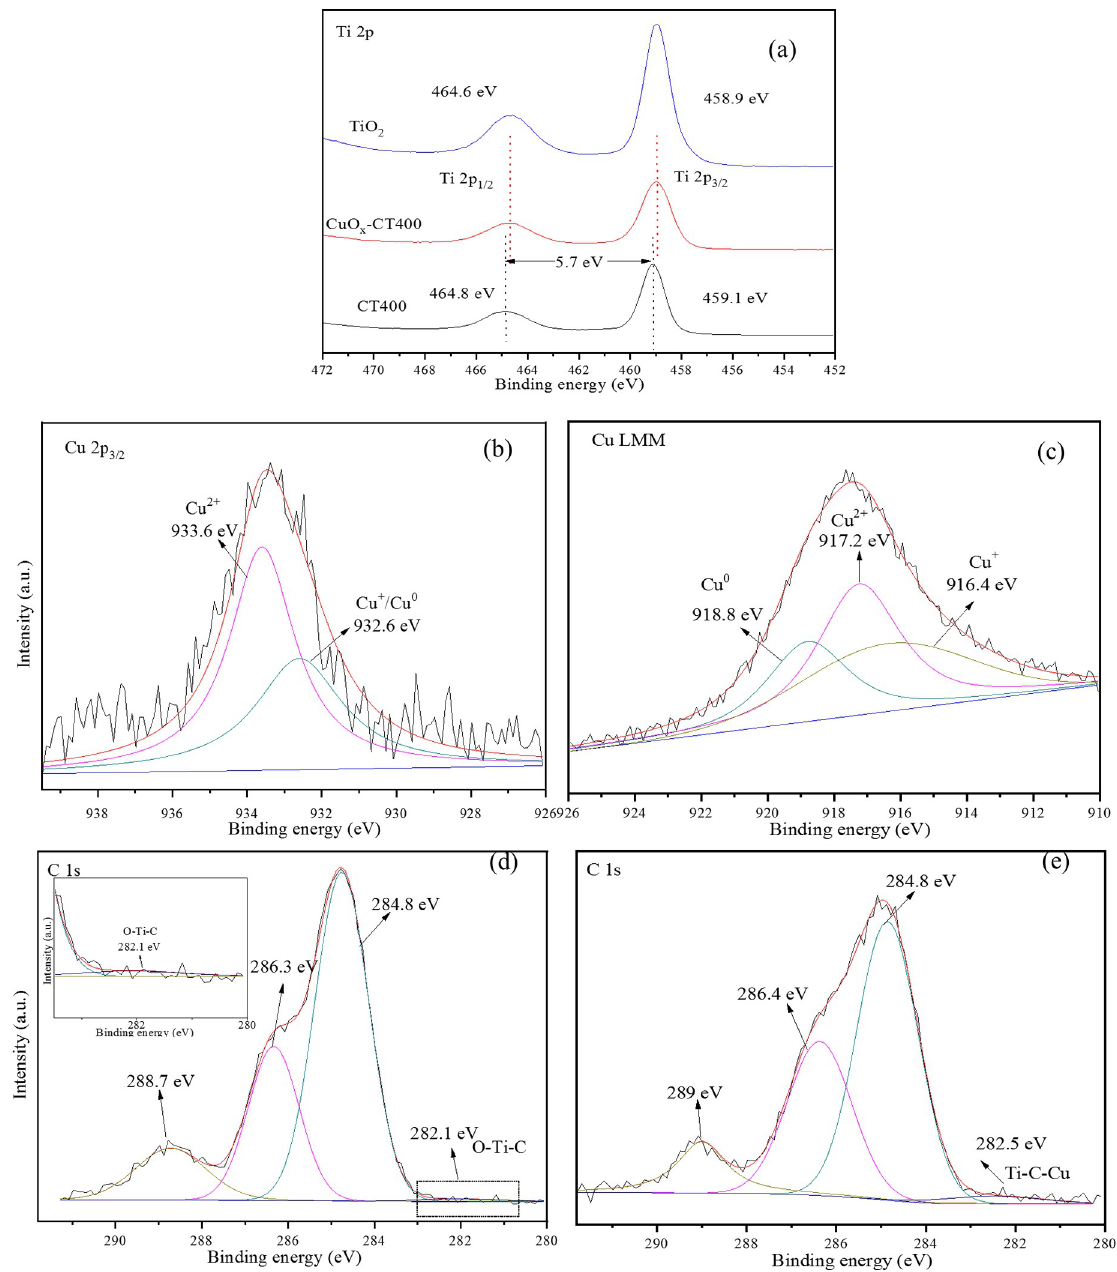
Fig 6. High-resolution XPS spectra of Ti 2p and Cu 2p for CuO x -CT400 (a, b), Cu LMM spectra for CuO x -CT400 (c) and C 1s spectra for CT400 (d) and CuO x -CT400